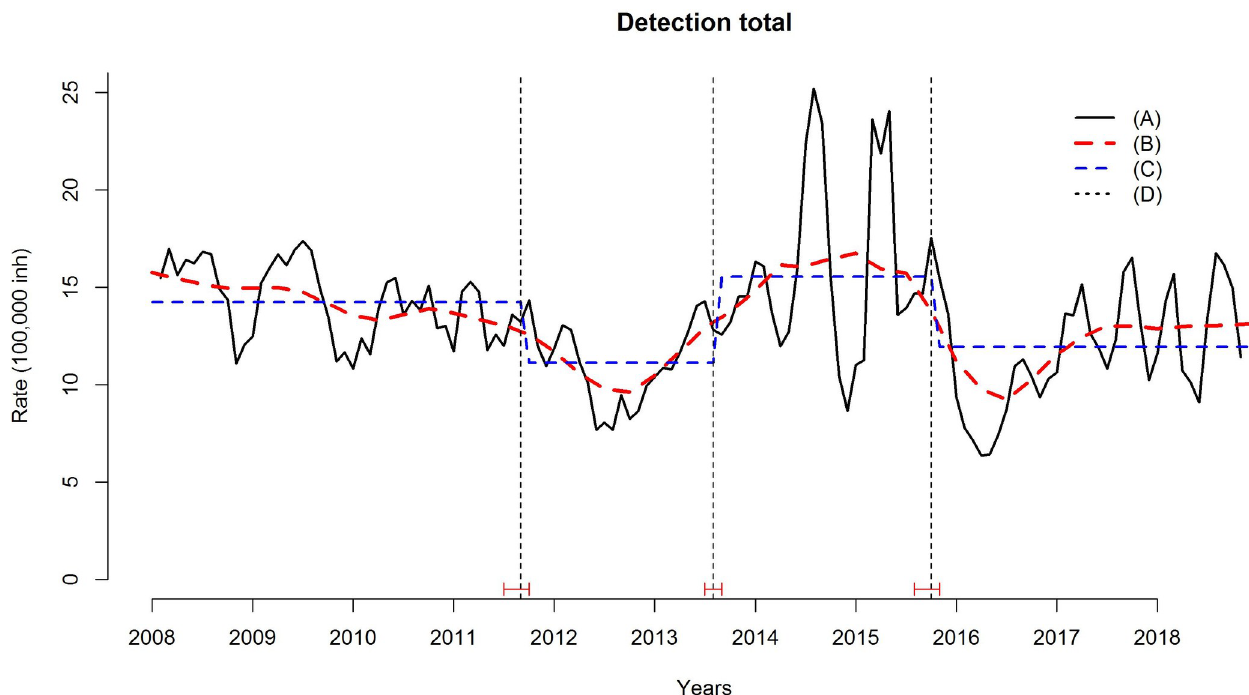
Fig 2. Changes in the structure of the time series for the general leprosy detection rate, Cuiaba´, Mato Grosso, Brazil (2008–2018). (A) Time series; (B) Trend; (C) Change of structure; (D) Point of structural change.